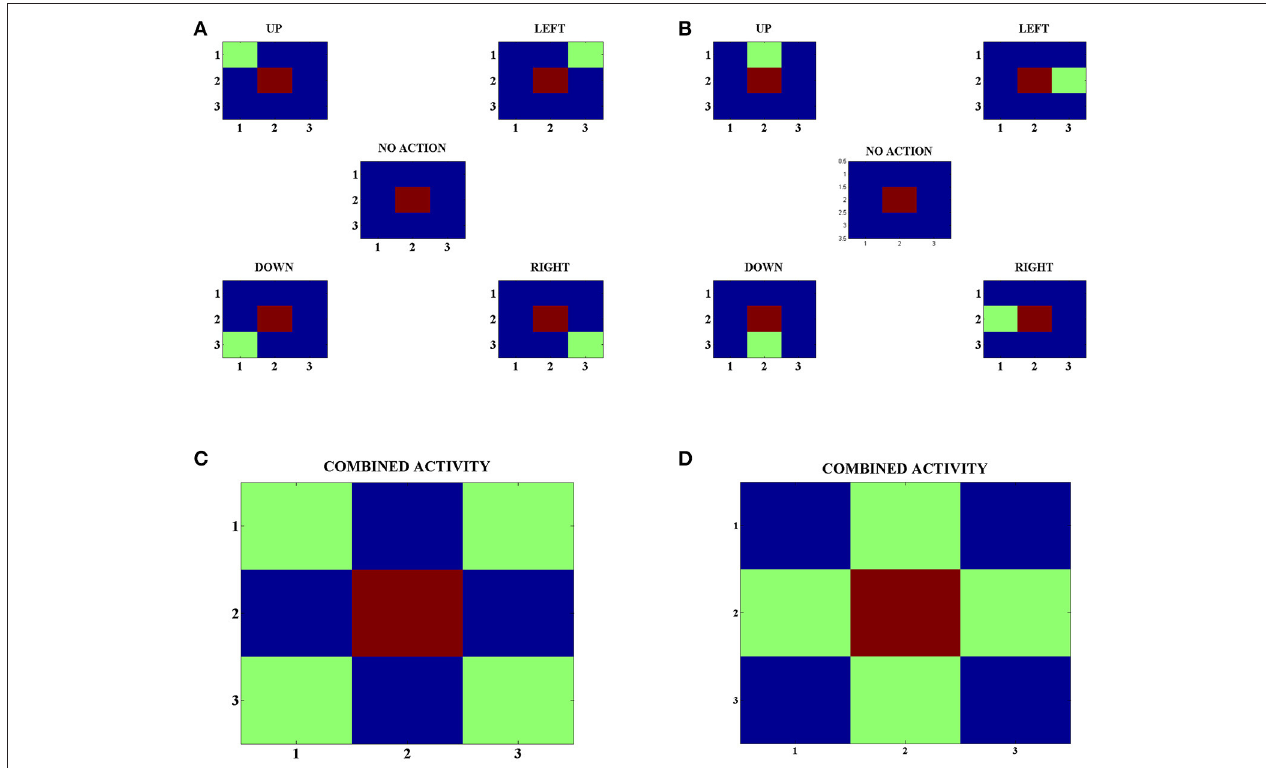
FIGURE 4 | (A) Activity of the Strio-SOM and the corresponding Matri-SOM neurons for different actions in a state. The center map shows only the activity of the Strio-SOM in the absence of any action and the other four maps in the corners show the activity of the Strio-SOM and the four possible Matri-SOM neurons that best respond to the particular action. (B) Same as (A) for another state. (C) Combined activity for all the action pairs in (A) . Shows one configuration of the center-surround mapping. (D) Combined activity for all the action pairs in (B). Shows another configuration of the center-surround mapping.